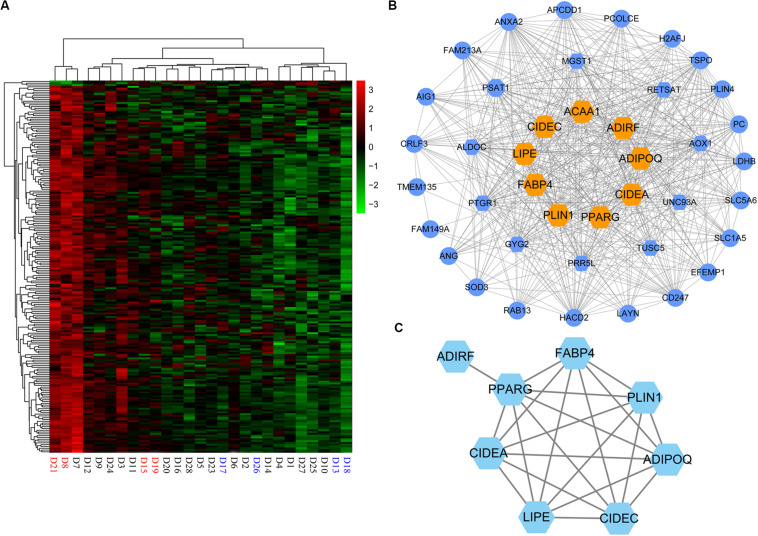
Hub genes in magenta module. (A) Heatmap of the magenta module genes. (B) Network visualization of the coexpression of 43 hub genes in magenta module. Hexagon represents 16 differentially expressed genes (DEGs) of the hub genes; orange hexagon represents nine DEGs in magenta module overlapping with 19 hub genes detected by functional enrichment analysis of DEGs. (C) Protein–protein interaction network of nine hub genes. ACAA1 without protein–protein interactions with the others is not displayed in the network.